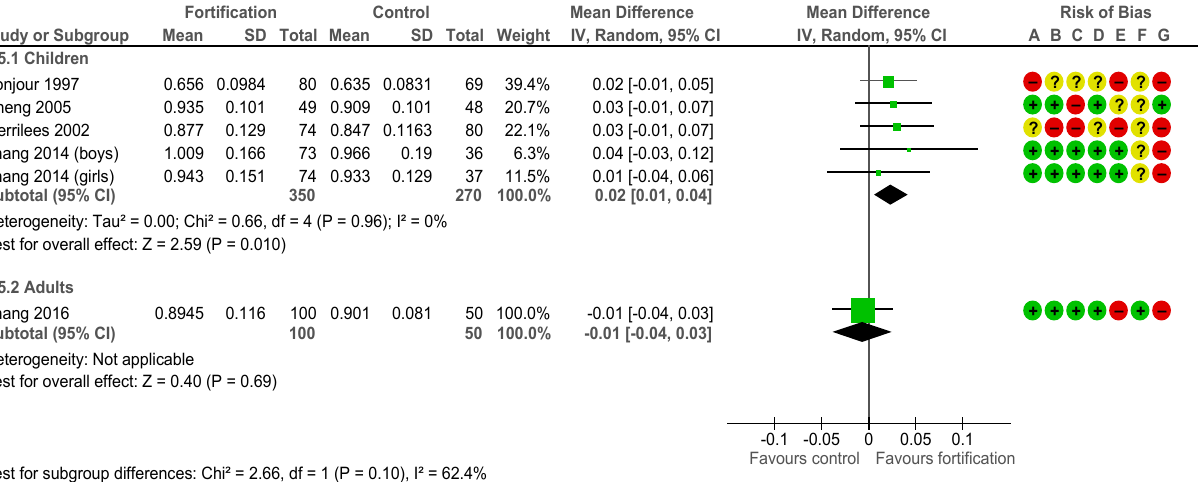
Figure 4. Impact of calcium fortification intervention on BMD femoral Neck (g/cm2) in RCTs [33,34,42,45]. The estimated effect of the fortification intervention on BMD Femoral neck inpre- monopausal women was − 0.01 g/cm 2 , (95% CI − 0.05 to 0.03) in one Non-RCT with a duration of 18 months [47] (Figure 5).